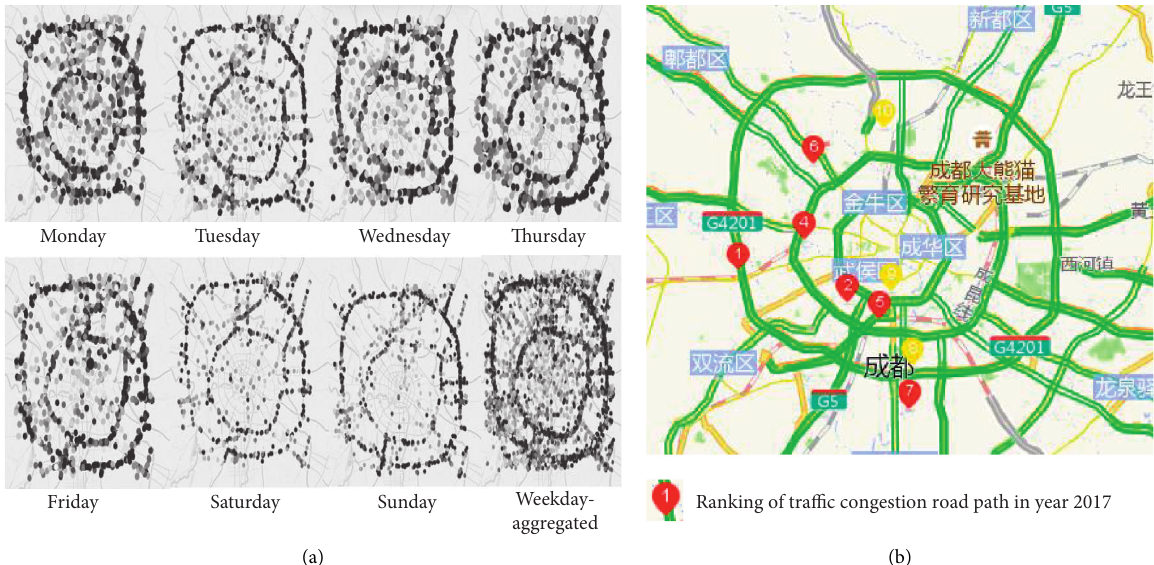
Figure 2: Background traffic flow of Chengdu city from August–October 2017.